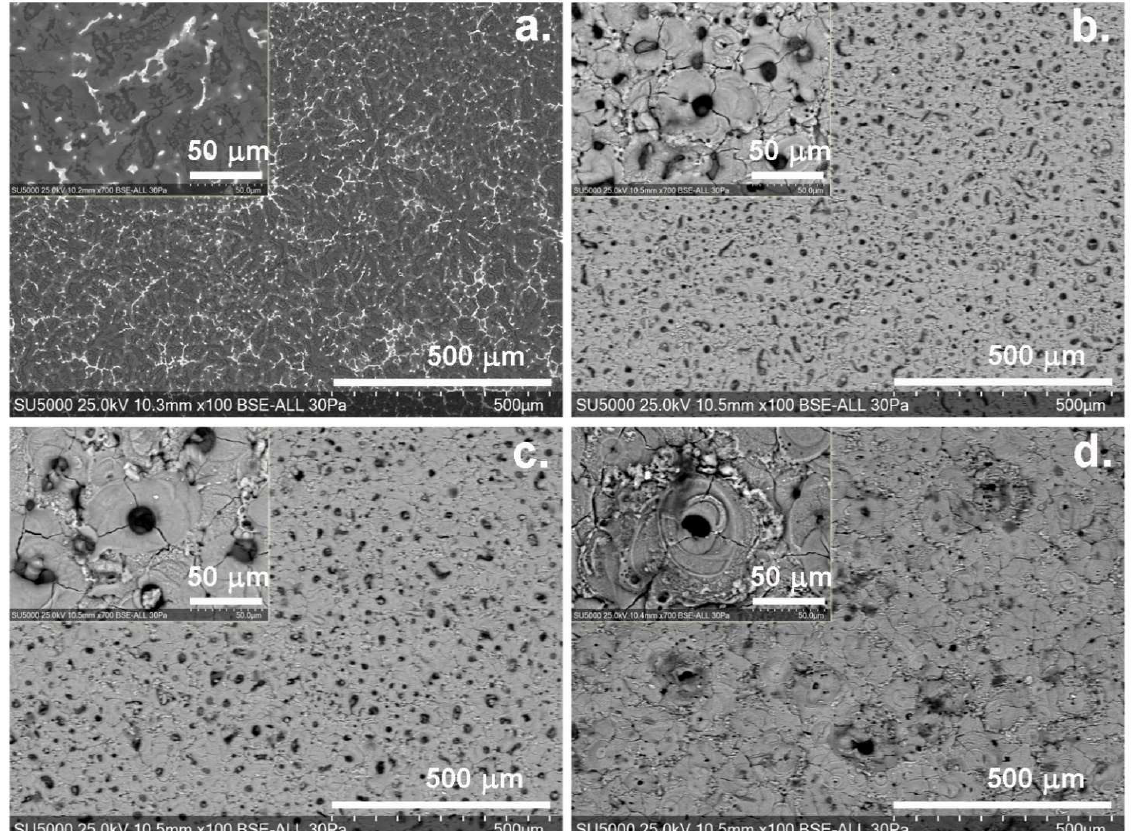
Figure 1. SEM images obtained at different magnifications (100 × and 700 × in zoom box) for raw Mg alloy ( a ) and PEO treated samples: AZ63_5m ( b ), AZ63_10m ( c ) and AZ63_20m ( d